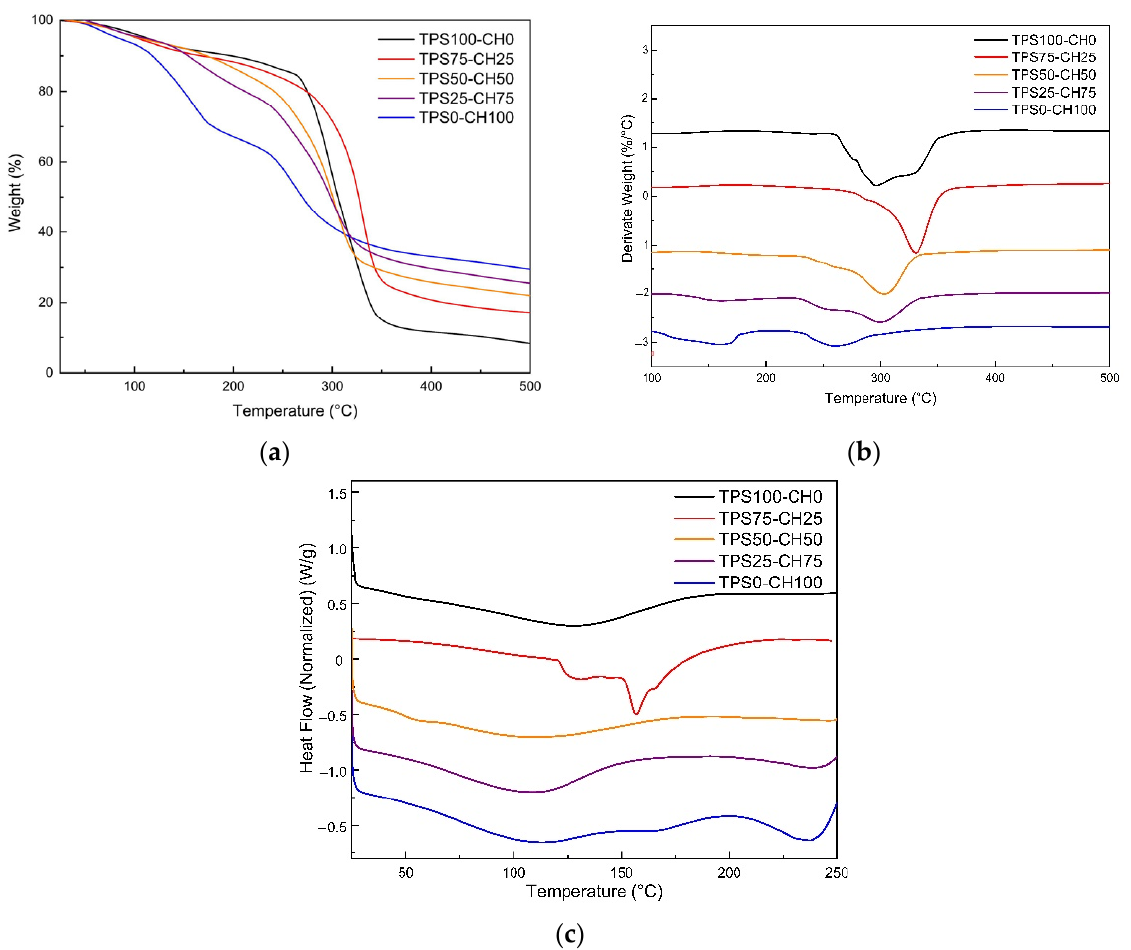
Figure 4. Thermal behavior of starch:chitosan films: ( a ) thermogravimetric analysis (TGA), ( b ) DTG, and ( c ) differential scanning calorimetry (DSC).